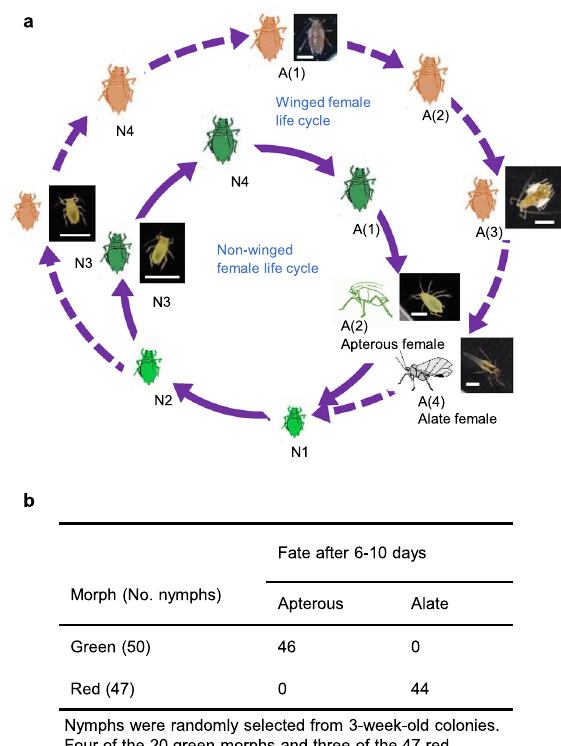
Fig. 2 Wing formation by Myzus persicae is linked to body colour. Red and green morphs of aphids from the same colony descended from a single mother have different fates in their life cycle. a Viviparous life cycle of green and red morphs. A: adult, N: nymph. The red and green nymphs were from uninfected stock plants. The aphid depiction was generated from our original photos. b Differences in fates between green and red morphs. All green morphs developed into apterous adults; all red morphs developed into alate adults. The adult stage could be divided into A(1) – A(4) based on changes in body colour, body size and wing-bud size. For detailed information, see the Supplementary Note 1 and ‘ Methods ’ . Scale bars = 1